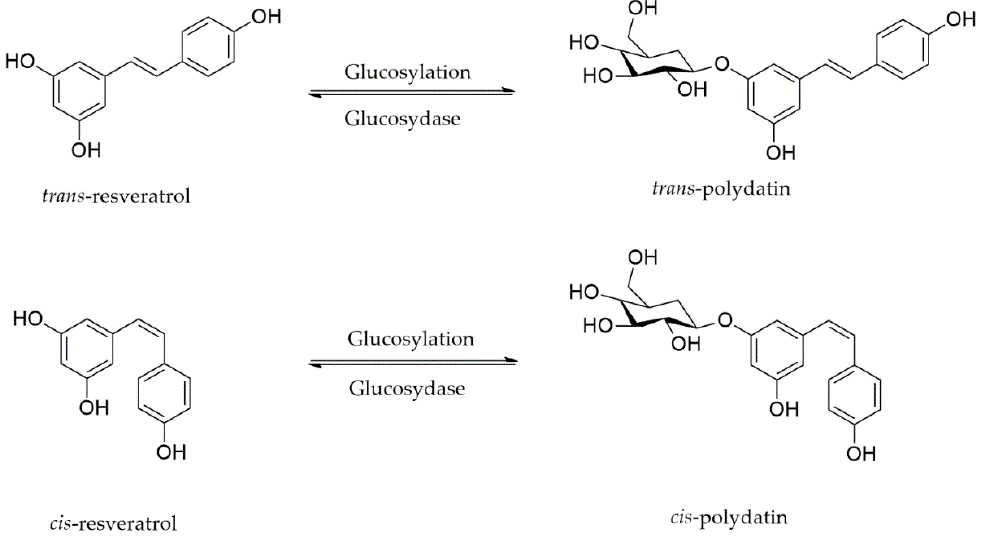
Figure 1. Polydatin, a glycosylated form of resveratrol.